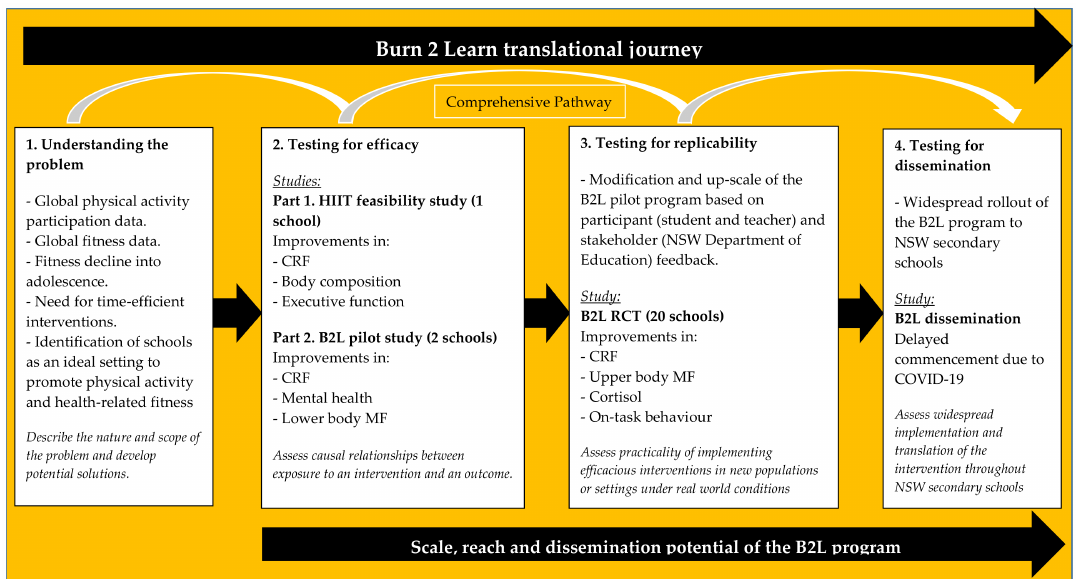
Figure 1. Burn 2 Learn (B2L) research progression model, including pathway to scale-up. Originally adapted from: Milat, Bauman [47] and Nutbeam and Bauman